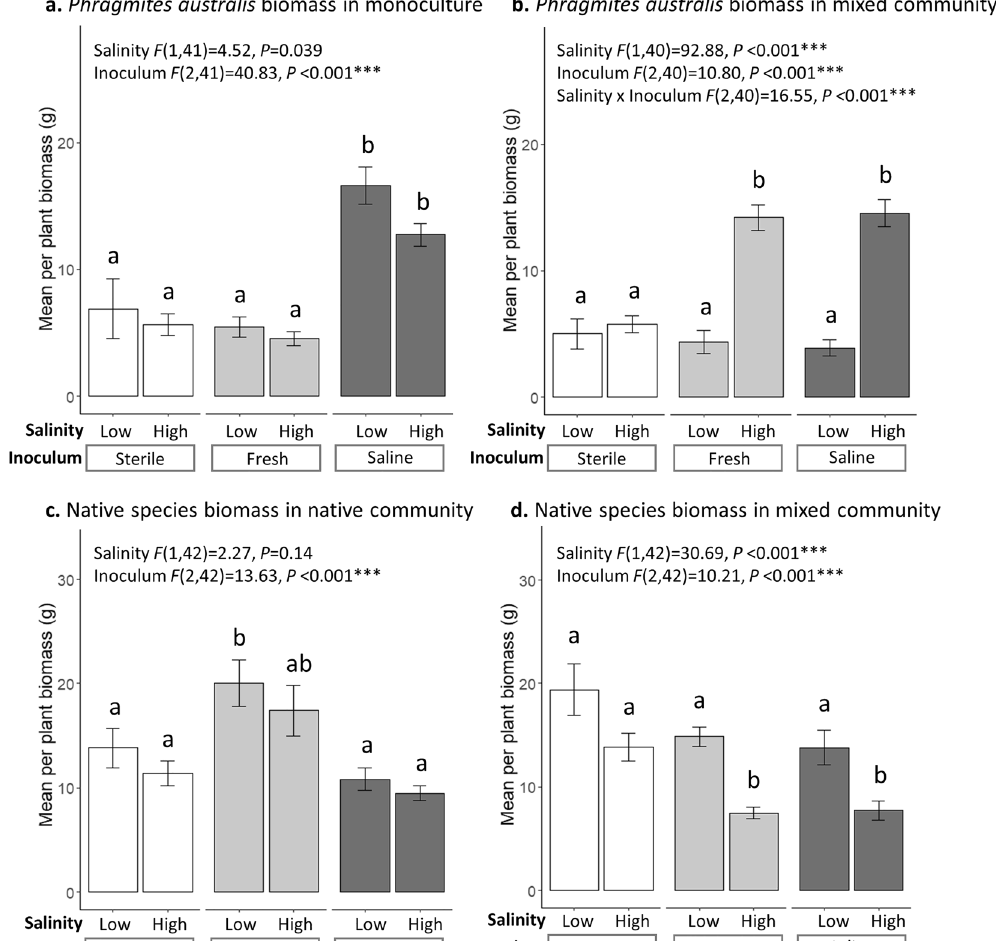
Figure 1. Effects of salinity (low and high) and inoculum (sterile, freshwater, and saline) on P. australis biomass in monoculture ( a ) and mixed communities ( b ) and on pooled native biomass in native communities ( c ) and mixed communities ( d ). White bars represent sterile soils, light grey bars represent freshwater inoculum treatments, and dark grey bars represent saline inoculum treatments. Error bars represent 1 standard error of treatment means. Two-way ANOVA results are presented. The salinity*inoculum interaction term was included in models if significant. Letters over the bars represent differences in means from Tukey post hoc tests. To visually compare biomass in different community types, total pooled biomass was adjusted to represent biomass per plant. For P. australis, total biomass was divided by six in monocultures and by three in mixed communities. For native species, total native biomass was divided by six in native communities, and by three in mixed